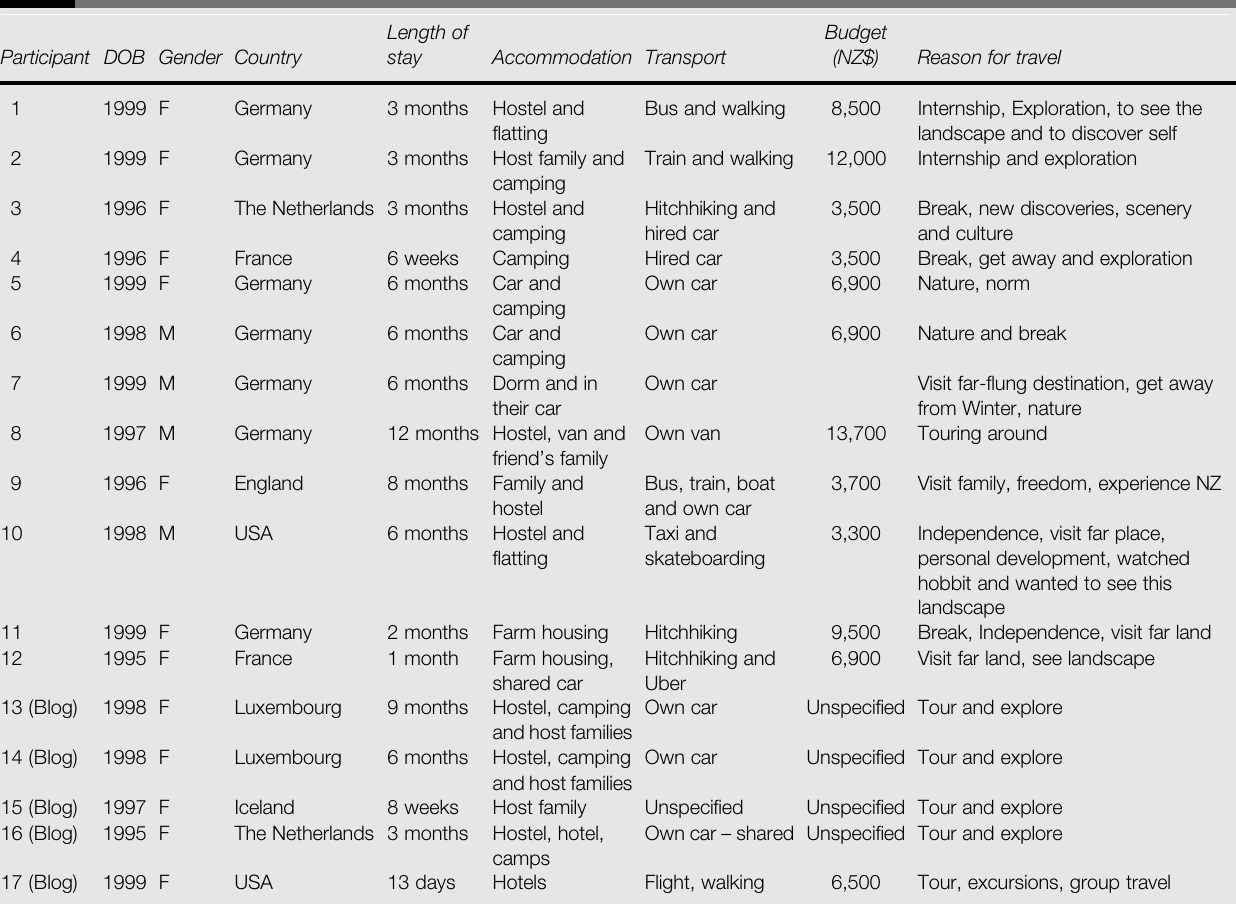
Table I Demographic profile of New Zealand inbound Generation Z participants Length Participant DOB Gender Country